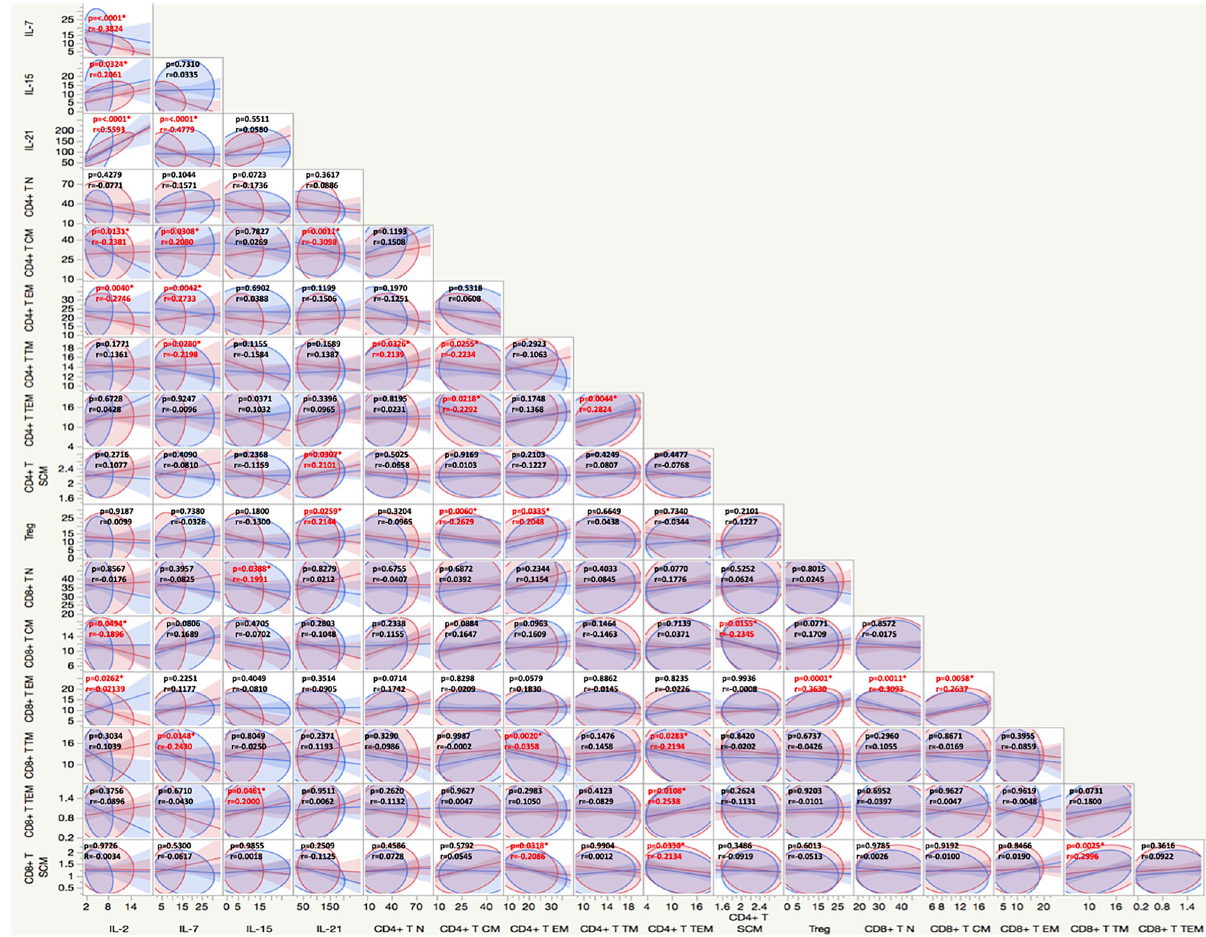
Fig 4. Relationship between CD4+ and CD8+ memory T cell subsets and γ c cytokines. Multiparametric matrix correlation plot of CD4+ and CD8 + memory T cell subsets, and γ c cytokines in all individuals with BCG pre-vaccinated and month 1 following vaccination. Spearman’s correlation coefficients are visualized. The blue line represents the x-axis parameter, and the red line represents the y-axis parameter.